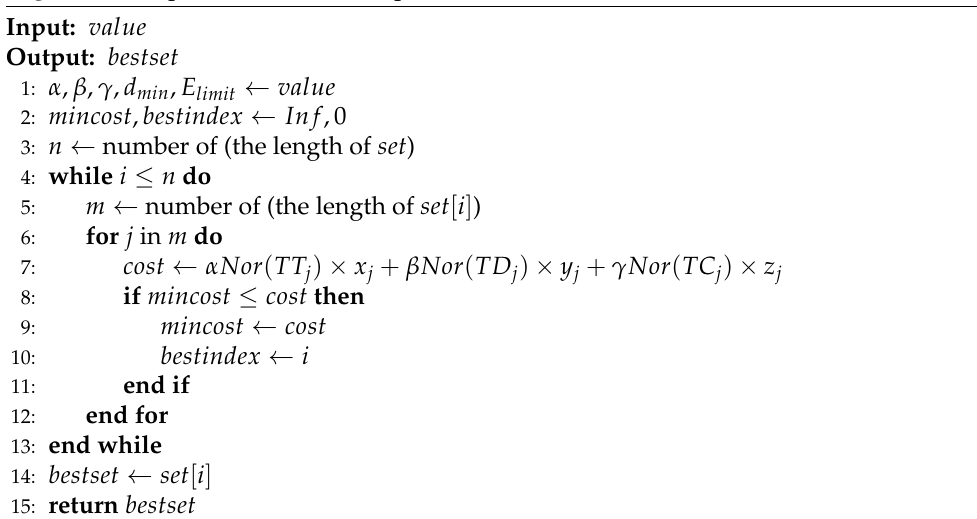
Algorithm 1 Optimization method